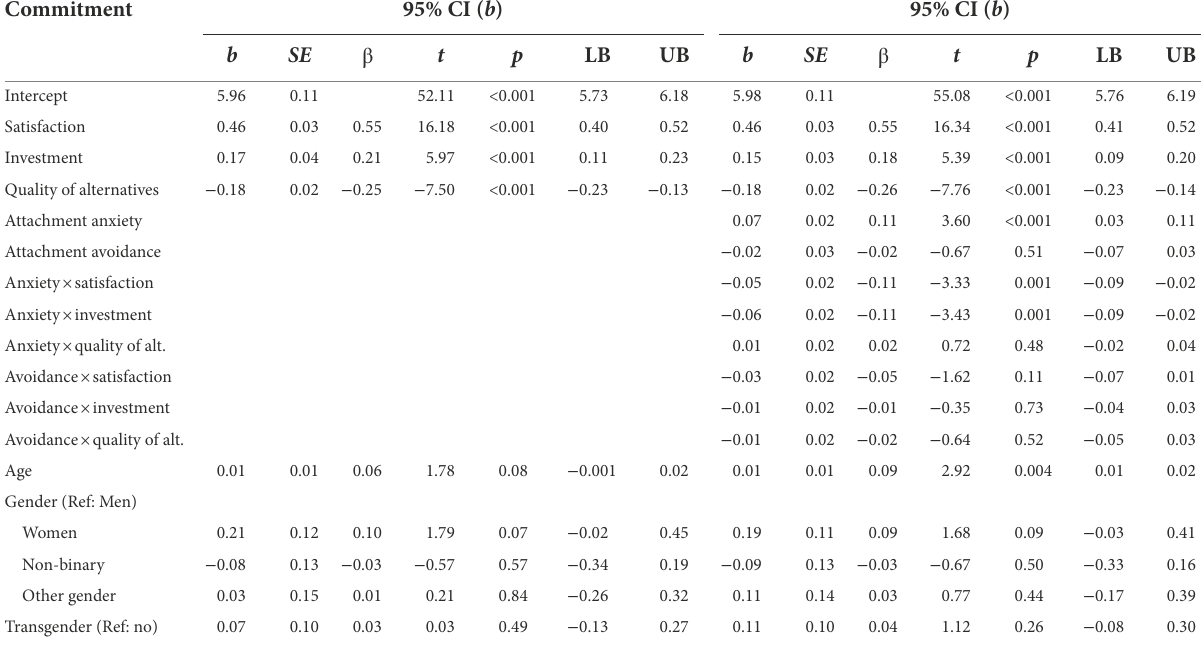
TABLE 2 The investment model and moderating effects of attachment.